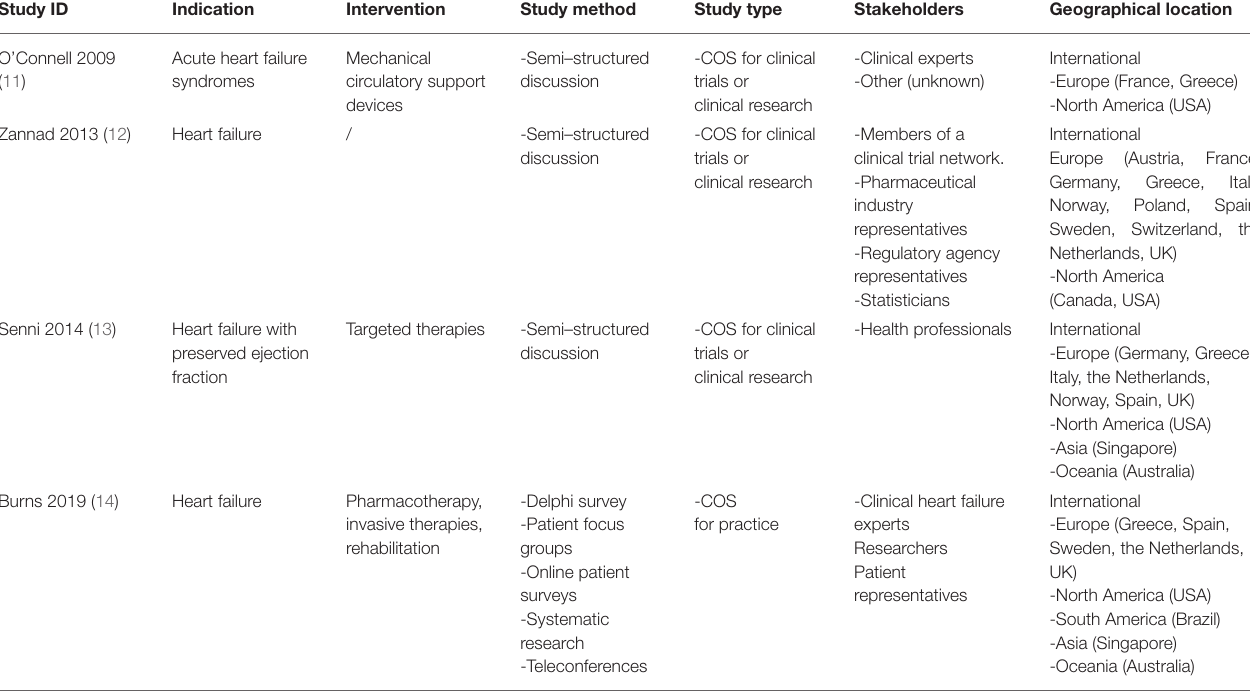
TABLE 1 | The characteristics of related core outcome set (COS) for heart failure.